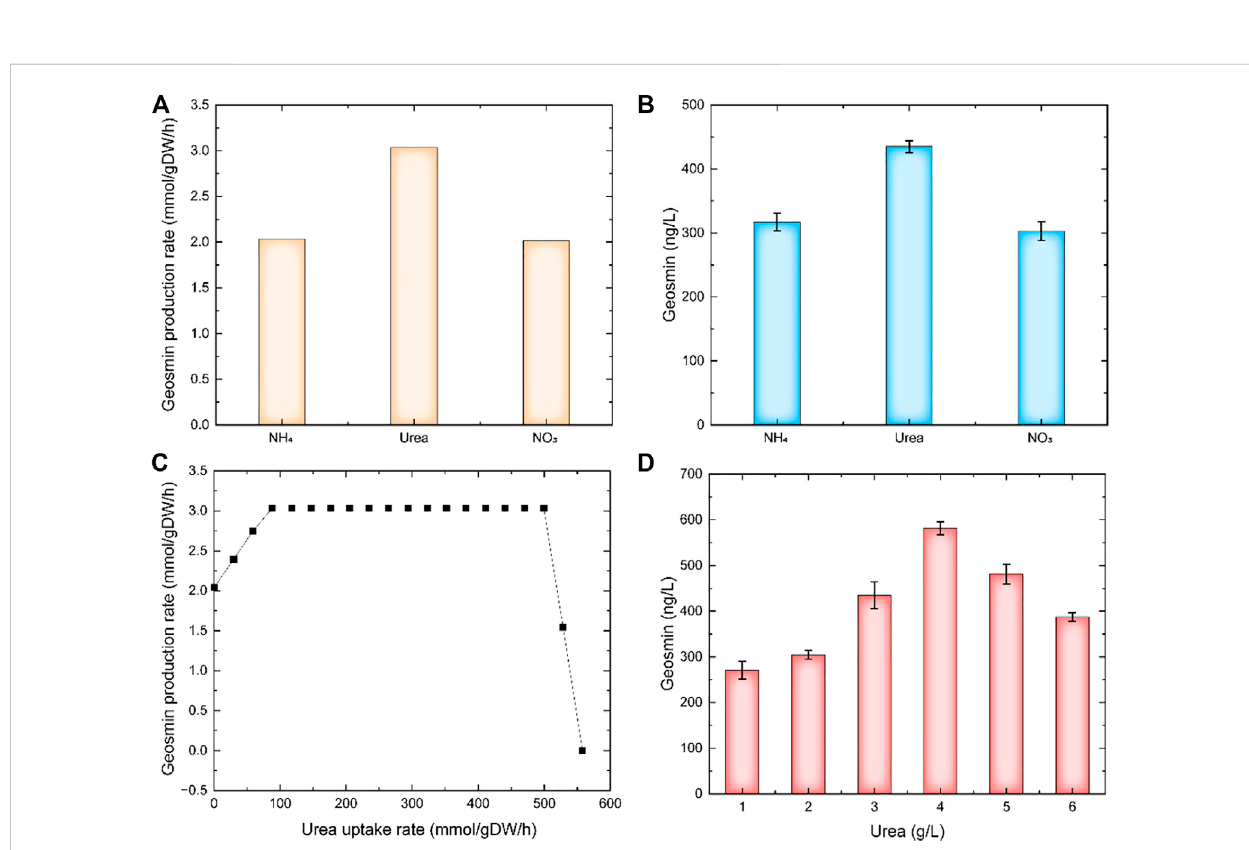
FIGURE 3 The effect of nitrogen sources on geosmin production. (A) simulation results of different nitrogen sources. (B) Experimental results of different nitrogen sources. (C) Robustness analysis results of urea uptake rate. (D) Effect of urea concentration on geosmin